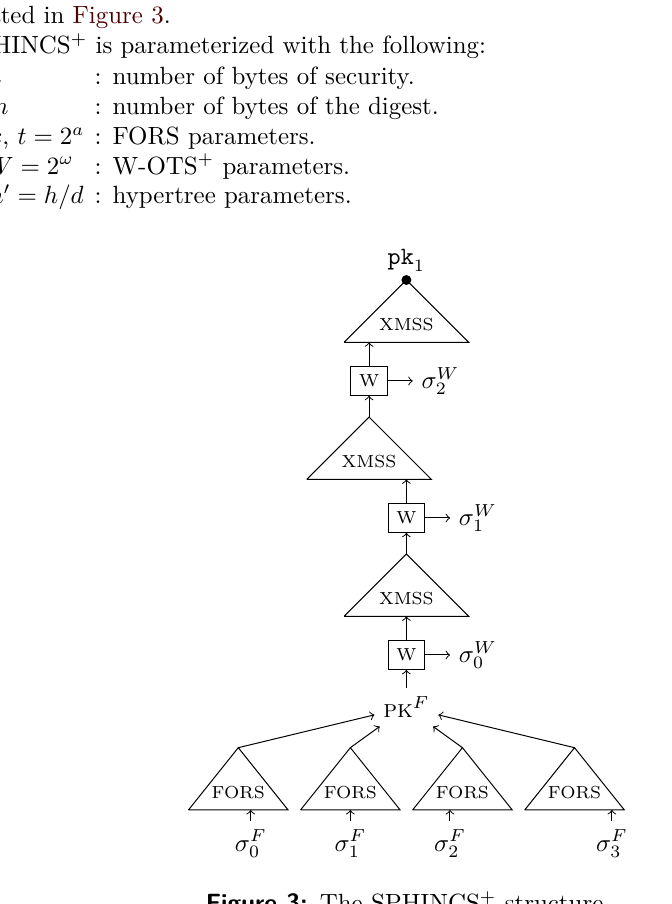
Figure 3: The SPHINCS +